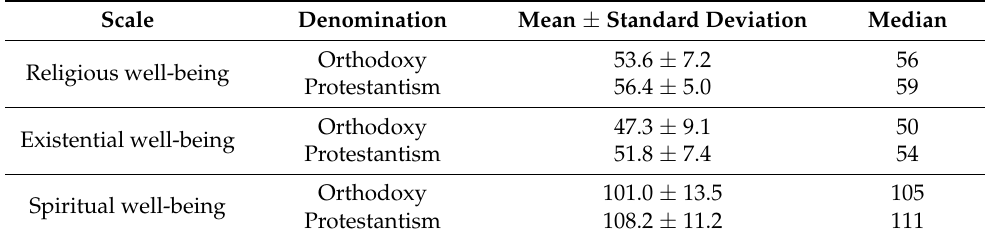
Table 4. Descriptive analysis of the Spiritual Well-Being Scale.